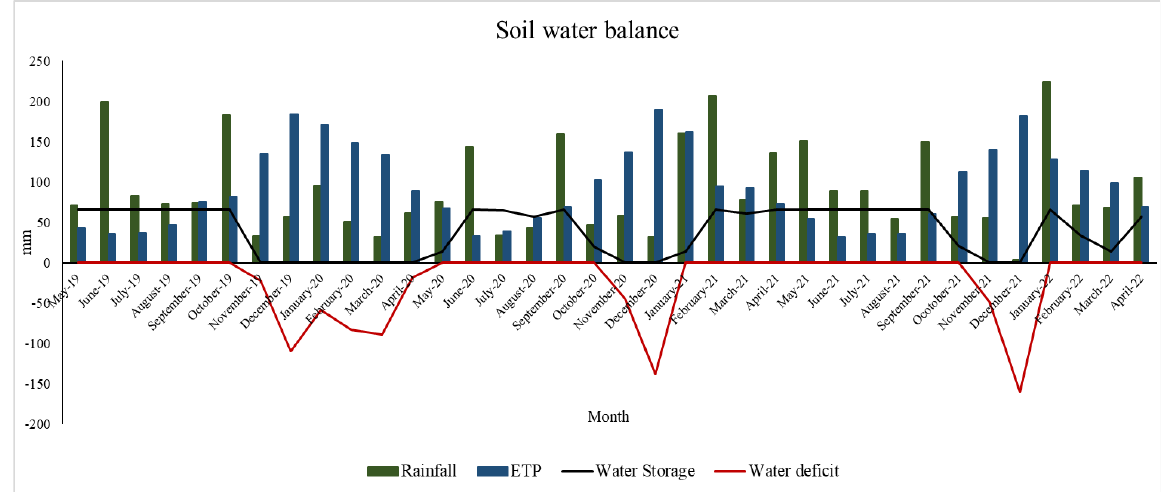
Figure 2. Soil water balance between May (2019) and April (2022) in the ‘Palo a Pique’ pasture–crop rotations long-term experiment in Treinta y Tres, Uruguay.